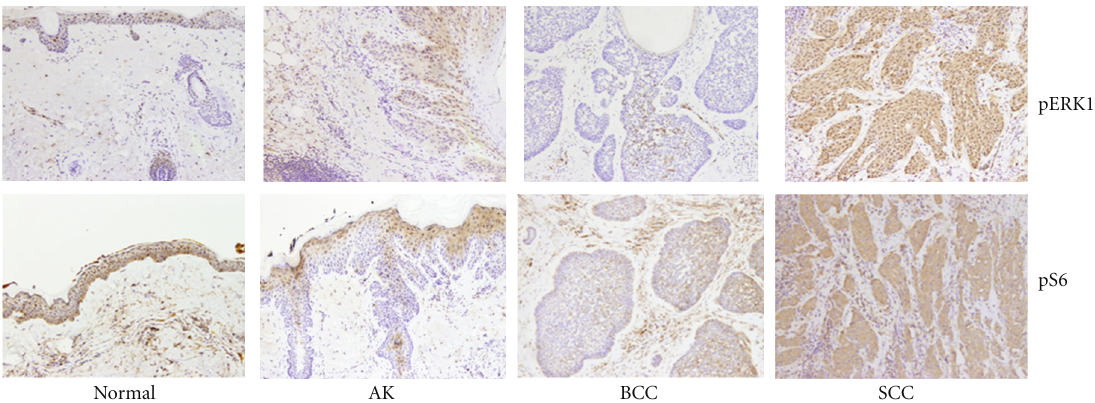
Figure 4: IHC analysis of pS6 and pERK expression in patients with negative (blue) staining and strong positive (brown) staining of tumor cells with pERK and pS6. Normal patient skin samples with minimal background staining and normal appearing cells. Representative actinic keratosis (AK) patient samples showing weak, cytoplasmic staining. Representative BCC patient samples with negative (blue) staining and few scattered positive (brown) staining of tumor cells. Representative SCC patient samples with strong positive (brown) nuclear and cytoplasmic staining with pERK and pS6. Note that the stroma stains positive (brown) in BCC, whereas the tumor stains negative